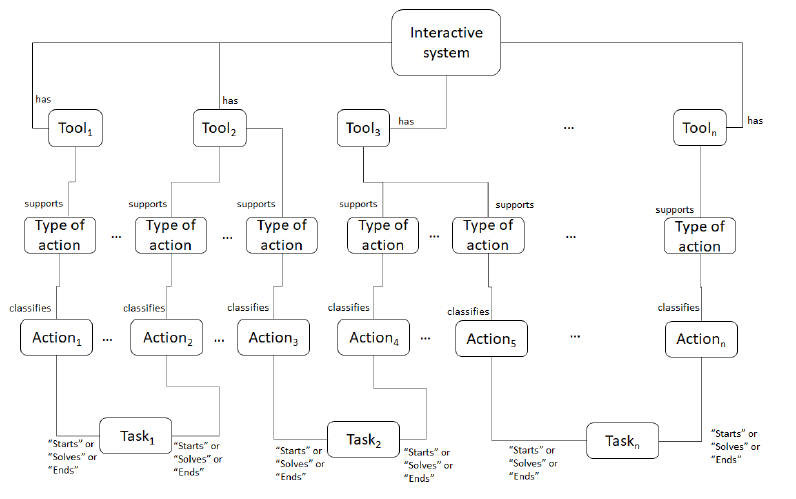
Figure 1. Structure of the task